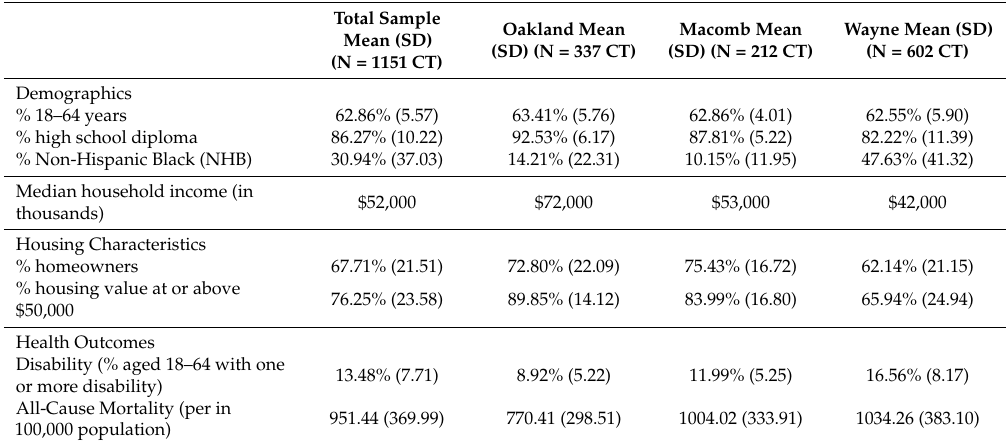
Table 1. Sample mean and standard deviation (SD) for all study variables in the DMA at the neighborhood level,